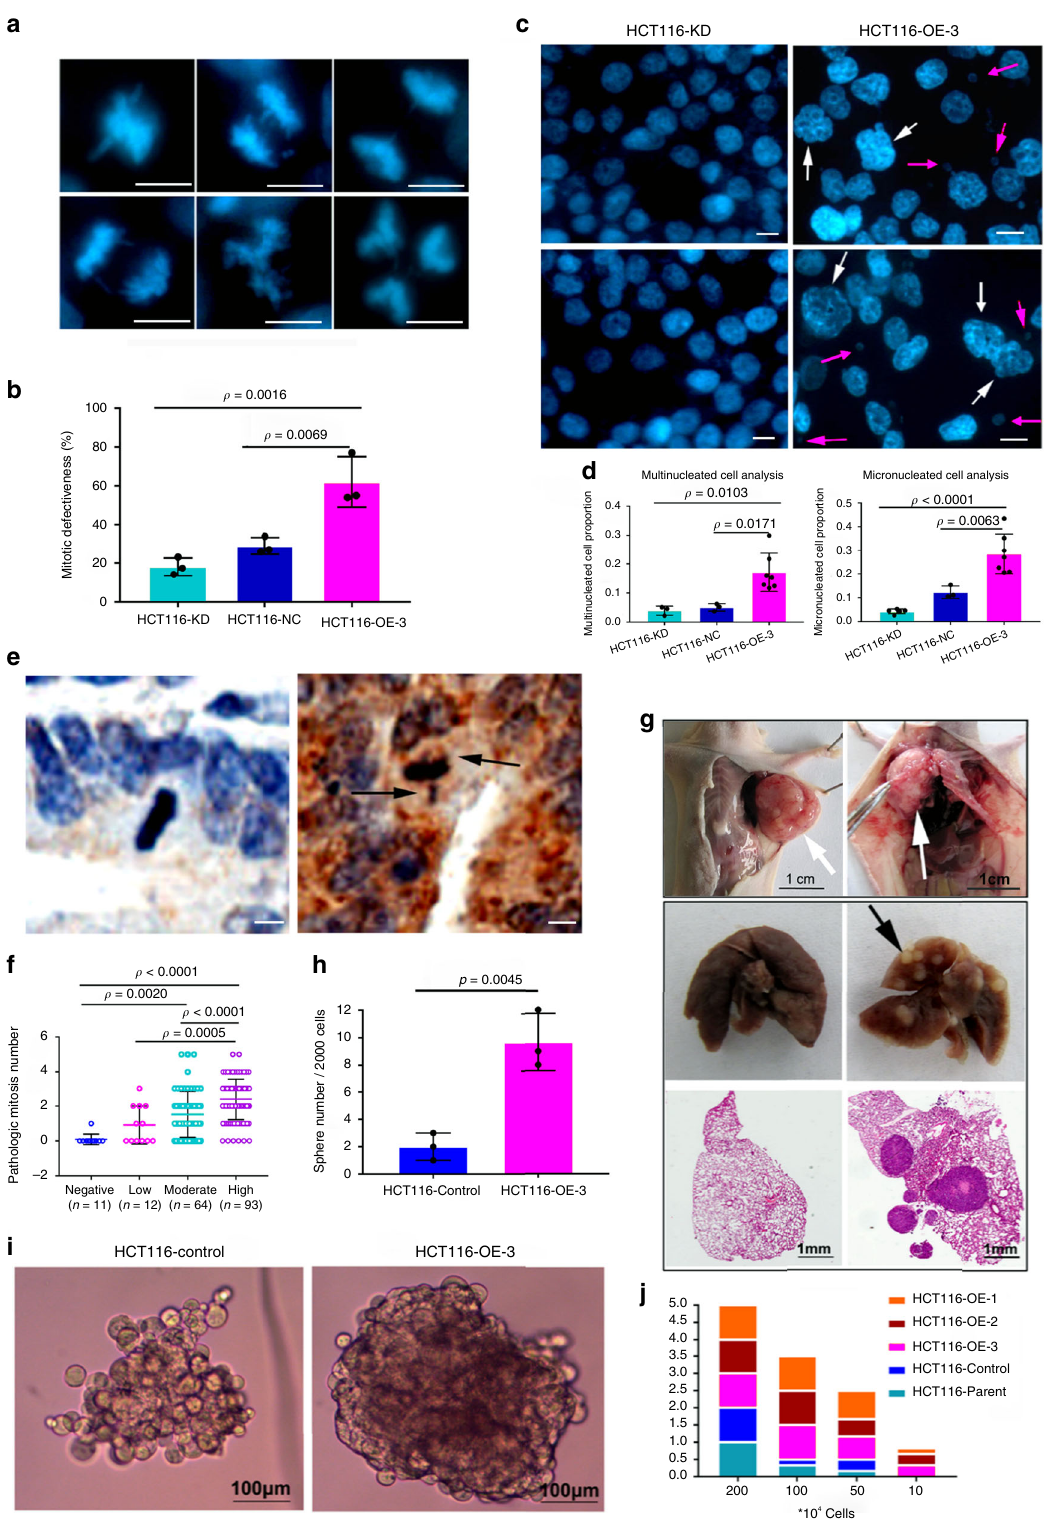
LC setup for the detection of the eluted peptides. Data-dependent MS/MS spectra were obtained simultaneously. Each scan cycle consisted of one full scan mass spectrum (m/z 300-1800) followed by 20 MS/MS events of the most intense ions with the following dynamic exclusion settings: repeat count 2; repeat duration 30s; and exclusion duration 90 s. The MS/MS spectra were automatically searched against the ipi.HUMAN.v3.53 using Bioworks Browser rev. 3.1 (Thermo Electron, San Jose, CA.). The protein identi fi cation results were extracted from SEQUEST out fi les with BuildSummary. The peptides were constrained to be tryptic and up